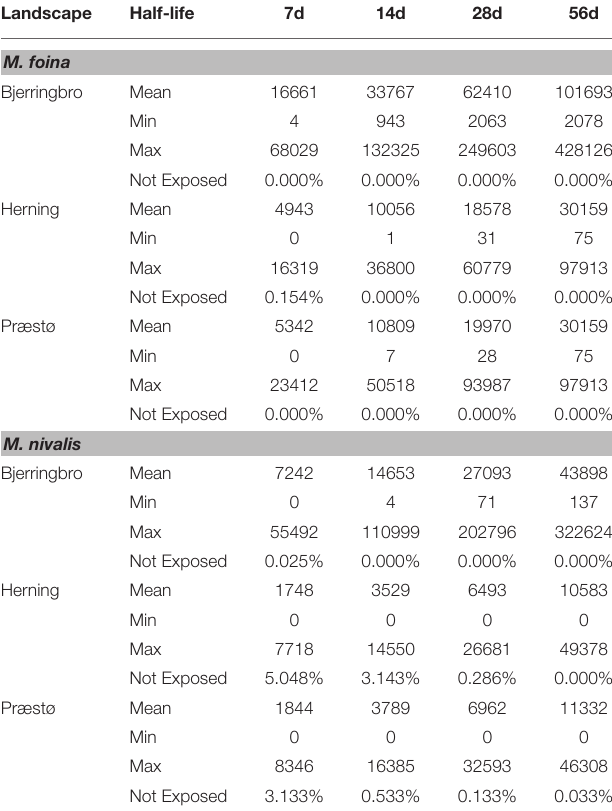
TABLE 6 | The effects of varying the environmental half-life parameter on exposure of M. foina and M. nivalis for three landscapes.